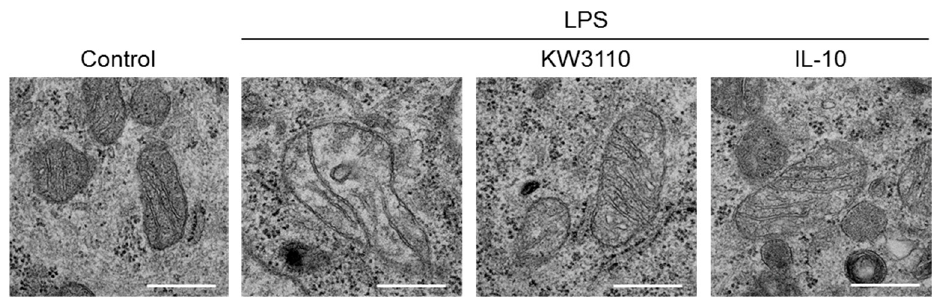
Figure 5. KW3110 or IL-10 treatment rescues disruption of mitochondrial structure in LPS-stimulated J774A.1 cells. J774A.1 cells were treated with KW3110 (1 µ g/mL) or IL-10 (1 µ g/mL) for 24 h, followed by stimulation with LPS (0.1 µ g/mL) for 24 h. Mitochondrial images were obtained with transmission electron microscopy. Scale bar, 400 nm.